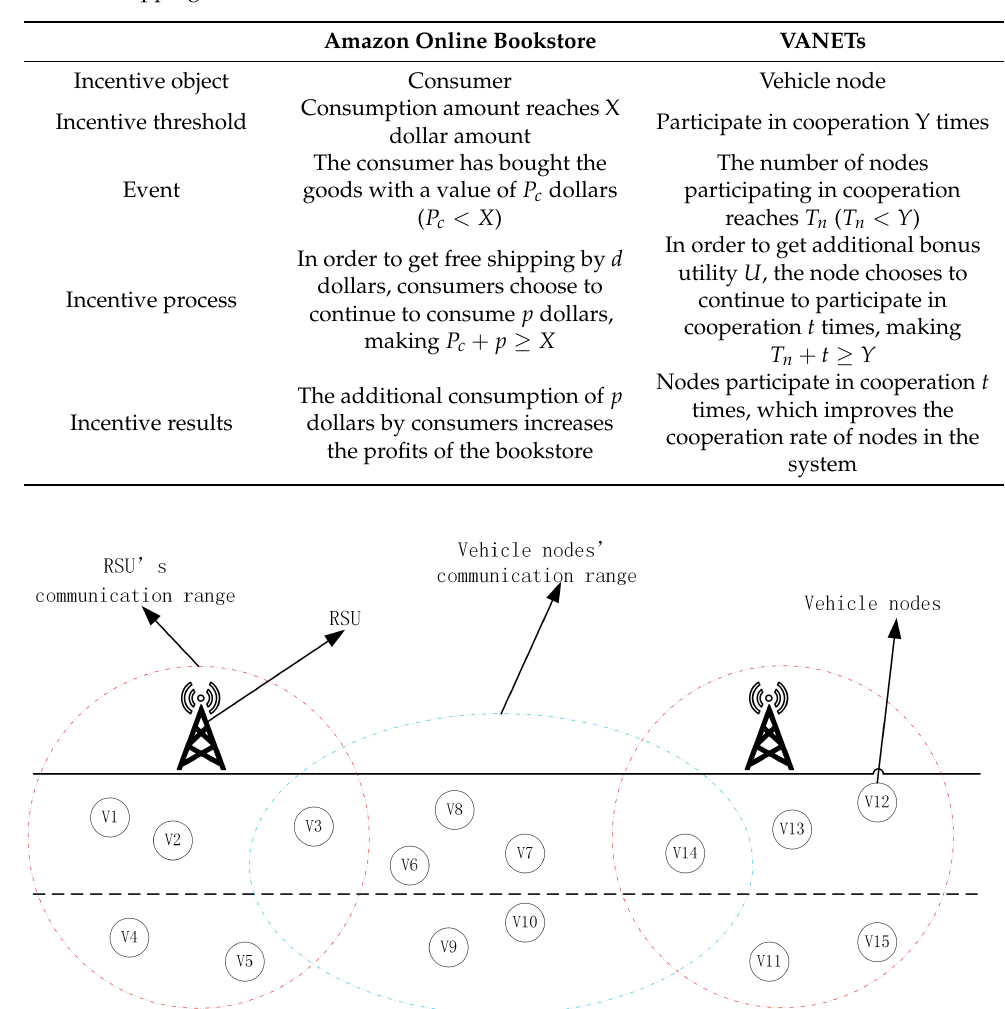
Table 1. Mapping of loss aversion in VANETs.